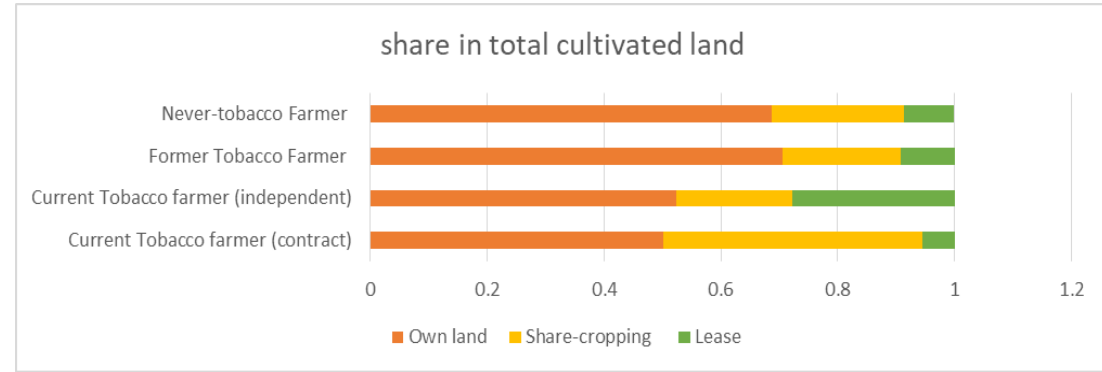
Figure 1. Composition of total cultivable land by ownership status.